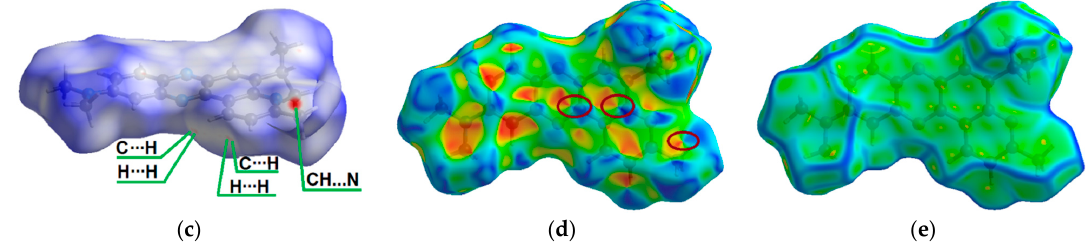
Figure 5. ORTEP diagram of 5-isopropyl- N , N ,3-trimethylpyrido[3,2- a ]phenazin-10-amine ( 6a ) with 50% probability. Top view ( a ), and packing ( b ). Hirshfeld surfaces for molecule 6a are mapped with d norm ( c ), shape index ( d ), and curvedness ( e ).